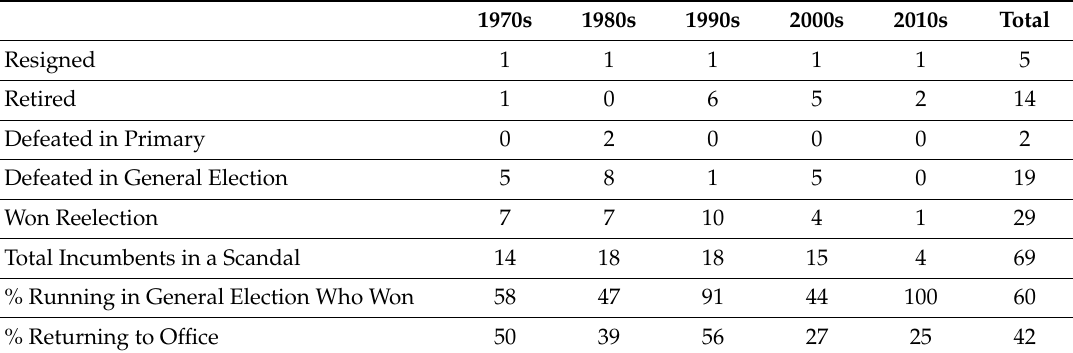
Table 2. Electoral outcomes of incumbents involved in a scandal,